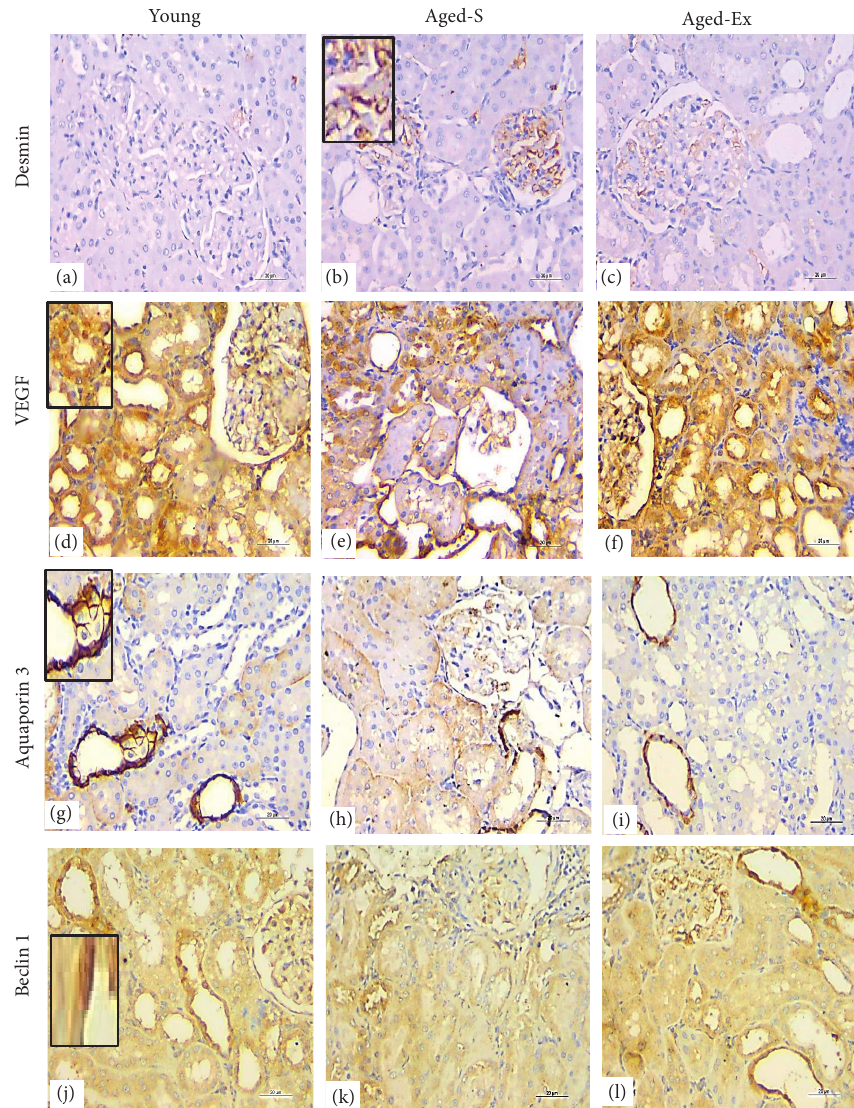
Figure 8: Representative immunostained renal sections of the different groups under study ( N � 10/group) showing upregulation of desmin (a-b), immunoreactivity with downregulation of VEGF (d-e), aquaporin-3 (g-h), and beclin-1 (j-k) immunoreactivity in the sedentary aged (aged-S) group compared with the control. Exercised aged rats revealing downregulation of desmin (c), immunoreactivity with upregulation of VEGF (f), aquaporin-3 (i), and beclin-1 (l) immunoreactivity compared with the aged-S group. The inserts indicate a positive reaction (40x, scale bar � 20 µ m). N � number of